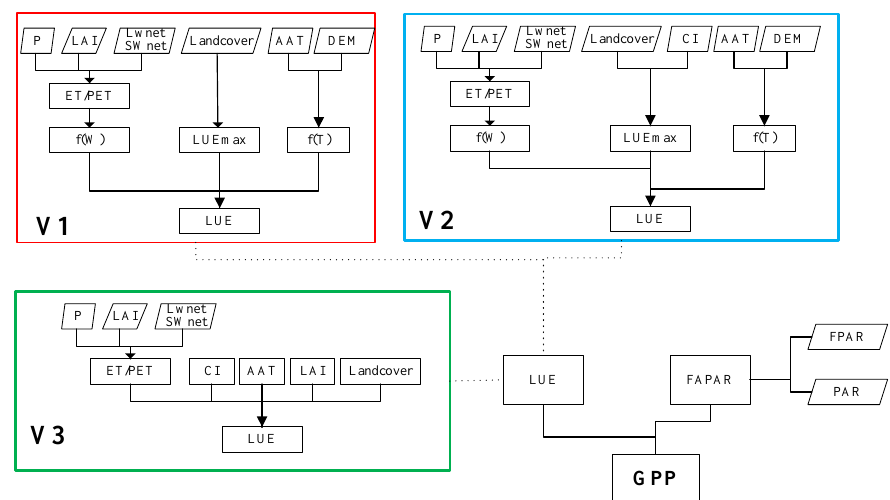
Figure 1. The flow chart of global Light use efficiency (LUE) and gross primary productivity (GPP) by 3 approaches.